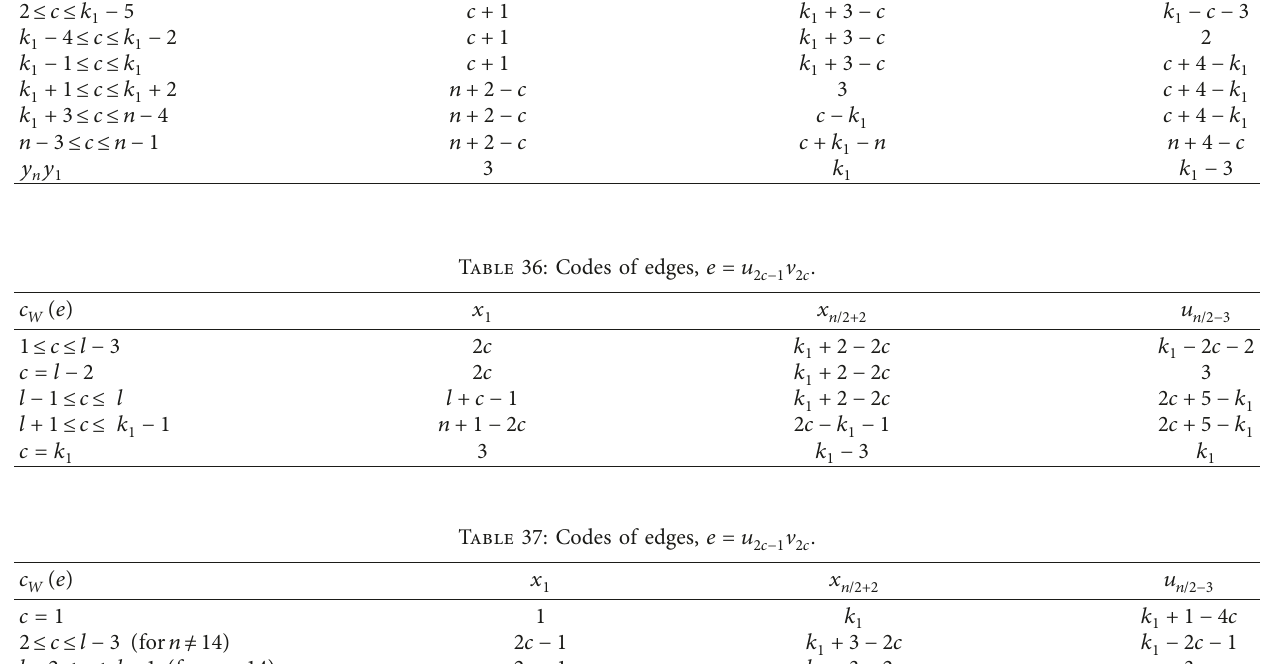
Table 35: Codes of edges, e � y